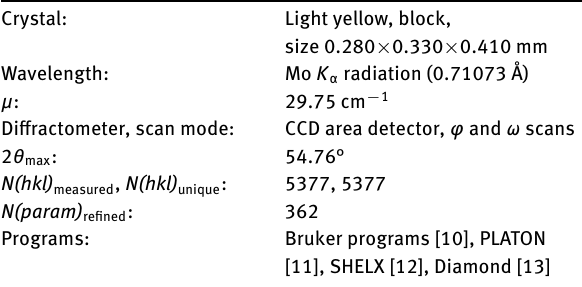
Table 1: Data collection and handling. Crystal: